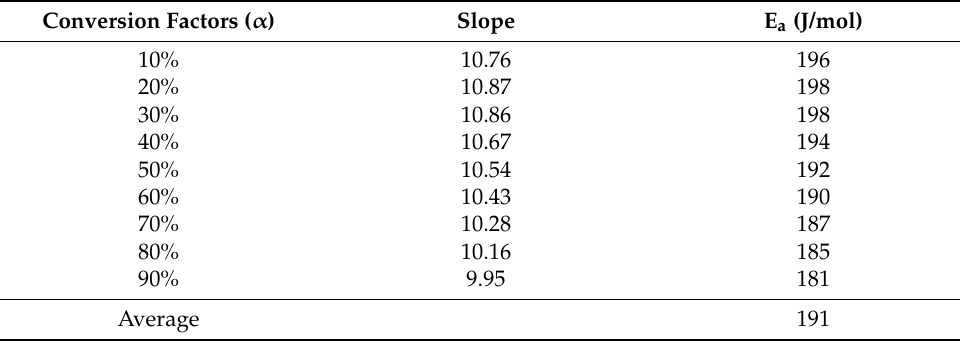
Figure 4. Apparent activation energy determination of PS. Table 3. Activation energy of PS at different conversion factors.